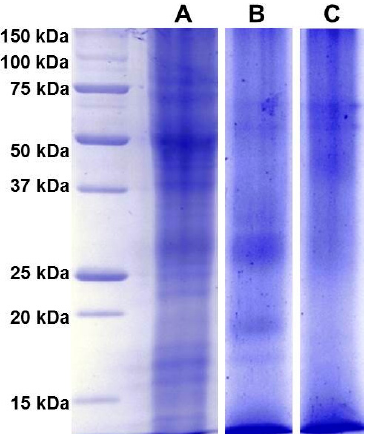
Figure 5. Proteins contained in dried Spanish saffron stigmas and styles ( A ), dried petals of Carthamus tinctorius L. ( B ) and dried fruits of Gardenia jasminoides ( C ) were separated by 1D-SDS-PAGE, and stained with Bio-safe™ Coomassie. The first lane at left contains molecular weight markers.